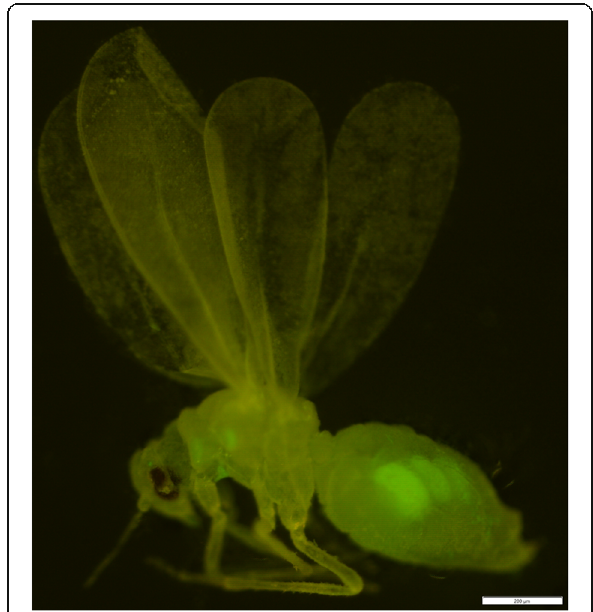
Fig. 3 The fluorescent localization of AME412 in Bemisia tabaci body